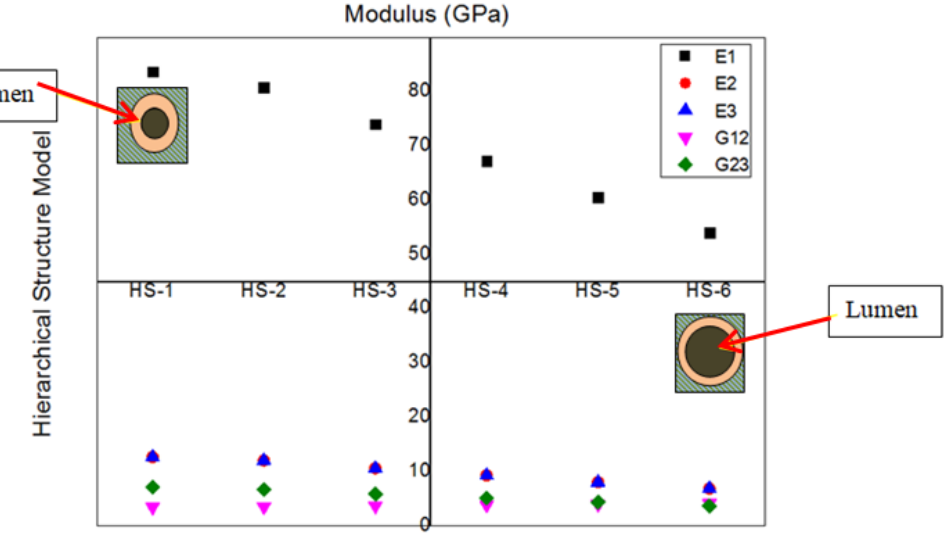
Figure 6. Modulus for different Hierarchical models. (Lumen is shown with red arrows). The ratio of lateral strain to the longitudinal strain of the composite material gives the Poisson’s ratio. Composite materials have two types of Poisson’s ratios. Major Poisson’s ratio ( ν 12 or ν 13 ) minor Poisson’s ratio ( ν 23 and ν 21 ). For transversely isotropic materials such as (E 2 = E 3 ), the magnitude of the major Poisson’s ratio ν 12 or ν 13 is the same and minor Poisson’s ratio ν 21 and ν 23 are same. However, the presence of lumen inside the JF makes the difference between the major Poisson’s ratio ν 12 and ν 13 and the minor Poisson’s ratio ν 21 and ν 23